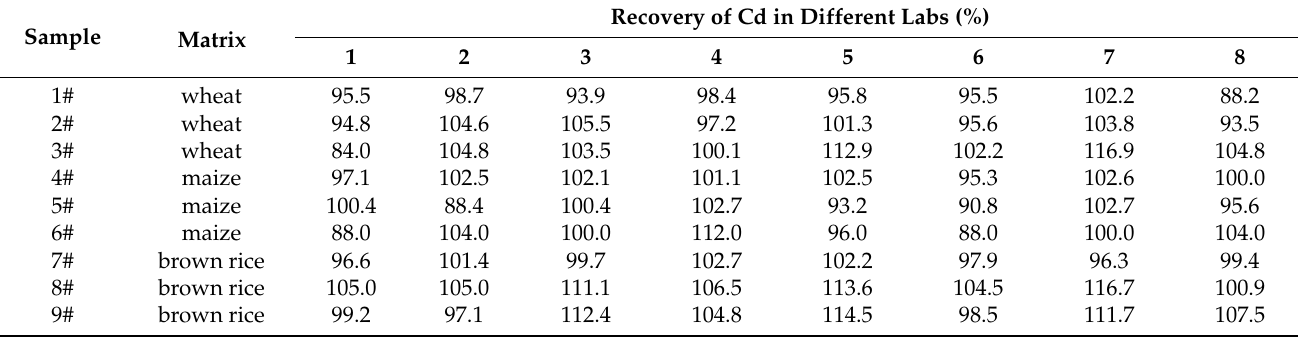
Table 8. Results of Cd by GFAAS with LCC-HCL in real samples (n =